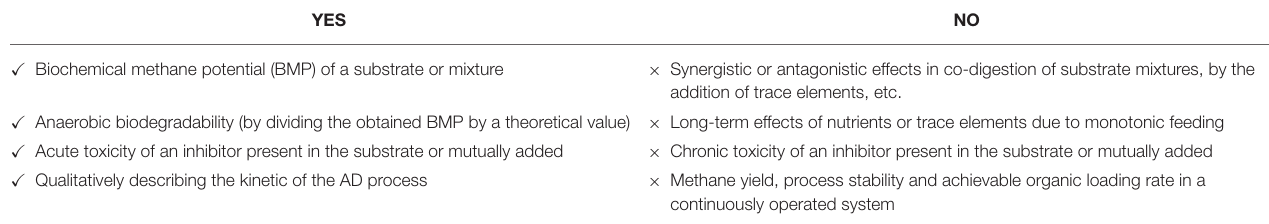
TABLE 1 | Power and limitations of BMP test. Is a BMP test suitable for the following applications? YES NO X Biochemical methane potential (BMP) of a substrate or